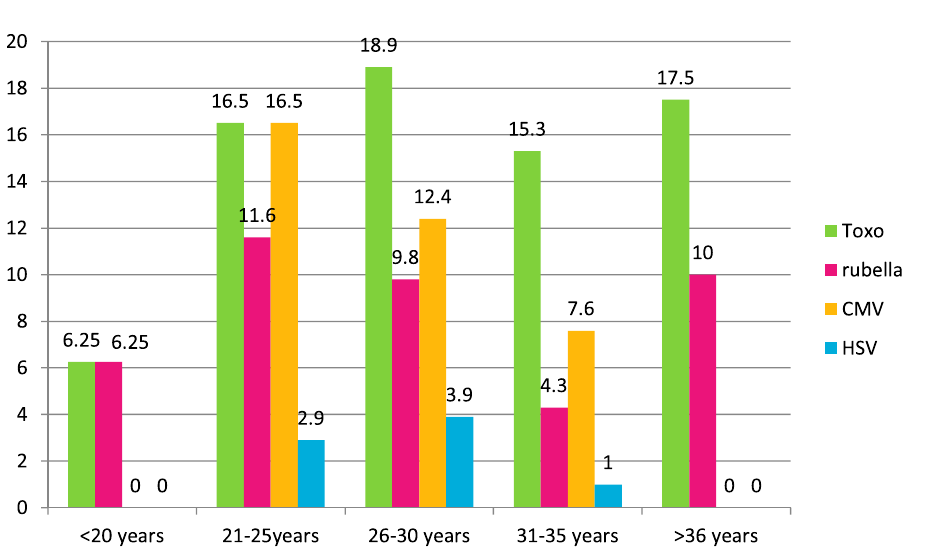
Fig. 1. Overall seropositivity of TORCH pathogens in different age groups